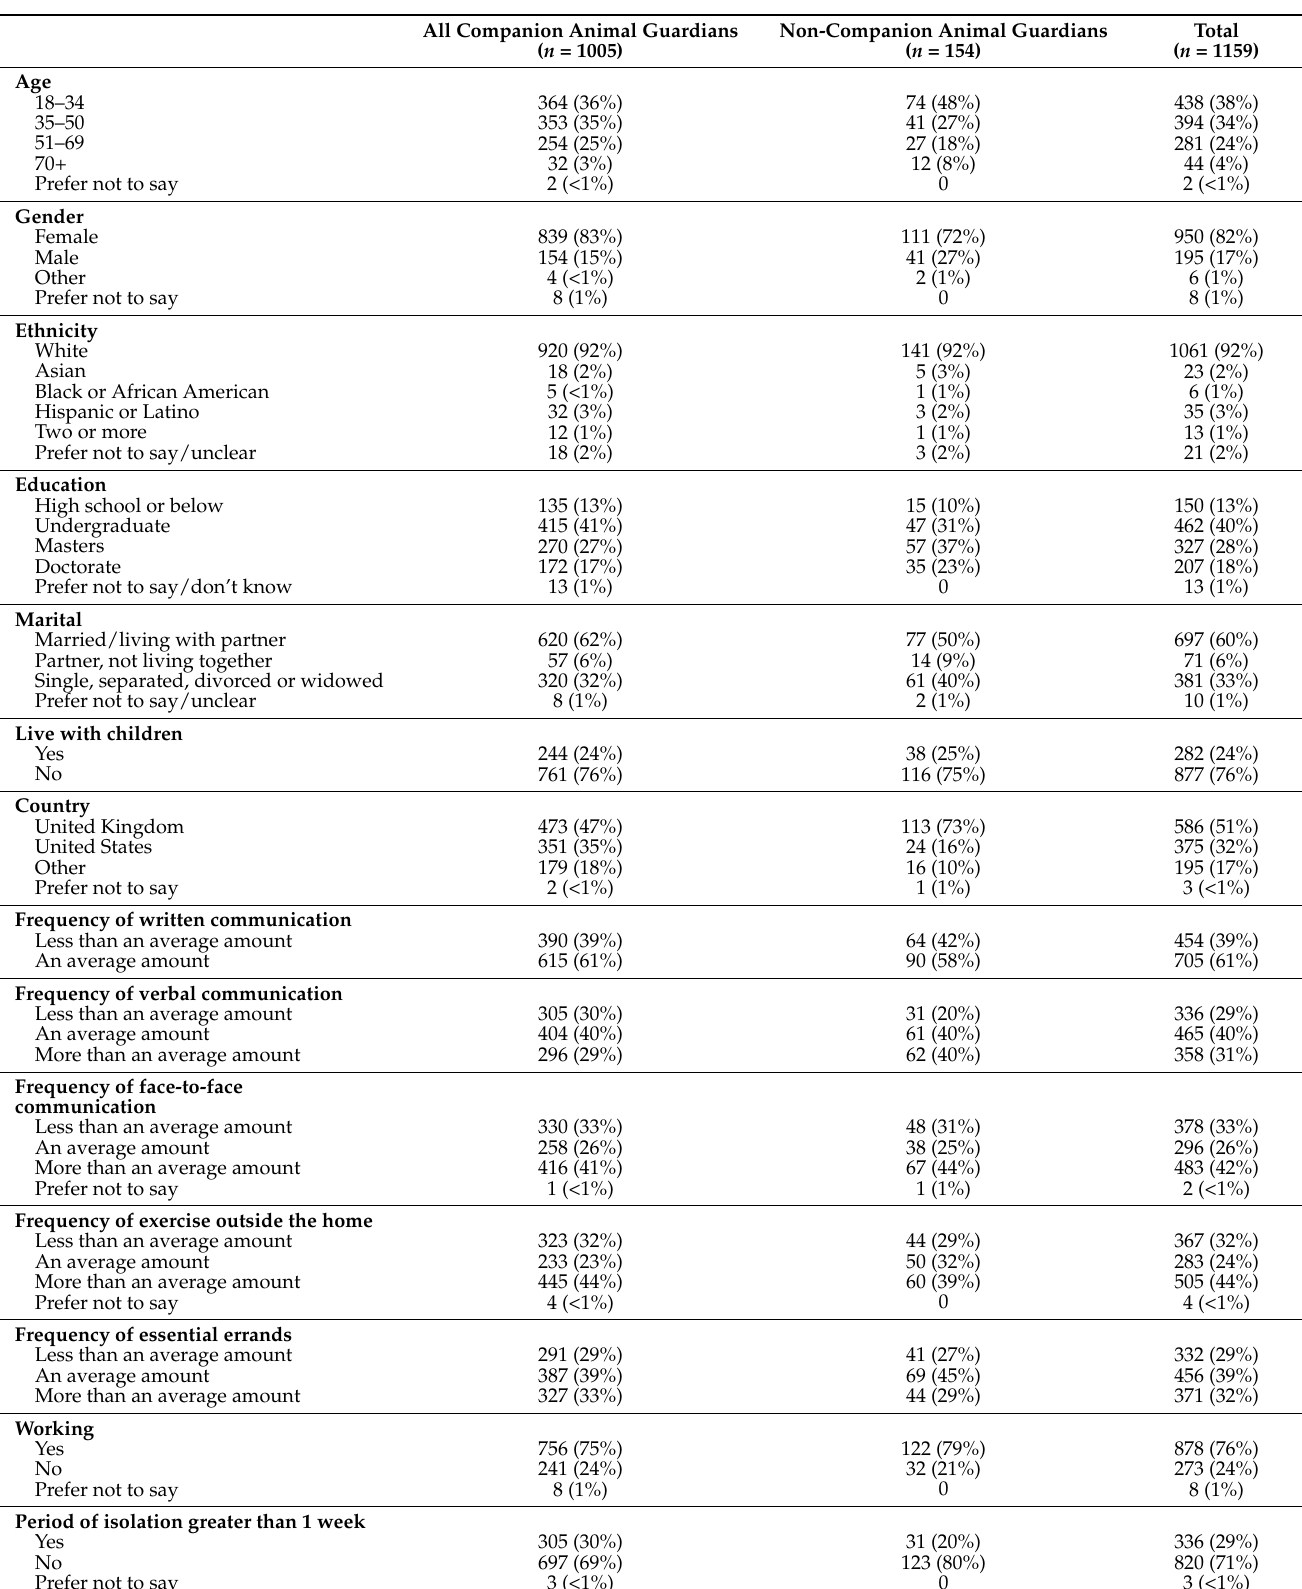
Table 2. Survey participant characteristics by companion animal guardianship